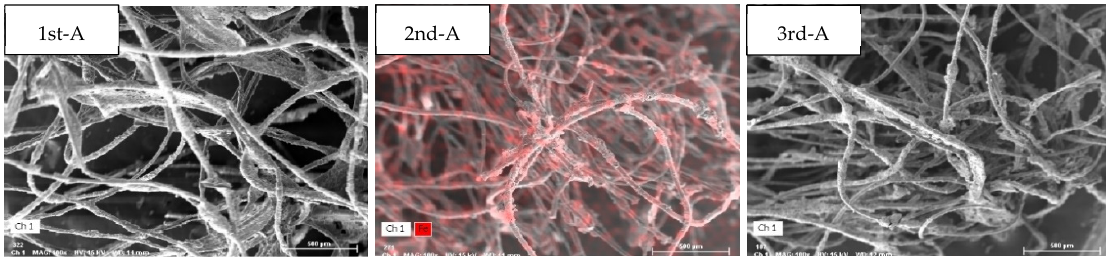
Figure 6. Element analysis of the supply air, using SEM-EDS, on May 23, June 28, and August 1.